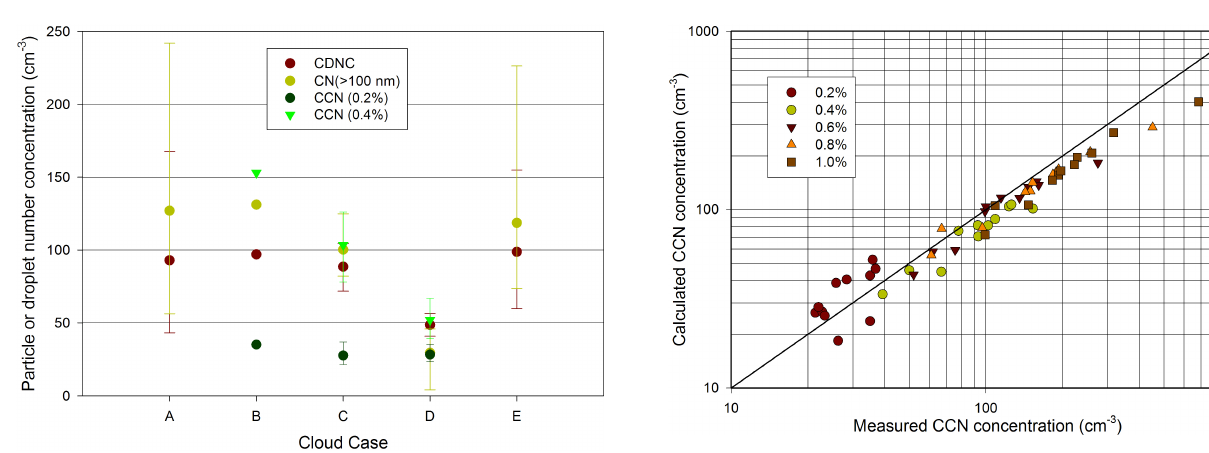
Fig. 4. The comparison of the cloud droplet concentrations (CDNC), the number concentrations of particles with dry diame- ter above 100nm, CN( > 100nm), and CCN concentrations at su- persaturations 0.2 and 0.4% for each cloud case. Here the symbols represent average values and the bars indicate the range over which the quantity varied during the event.